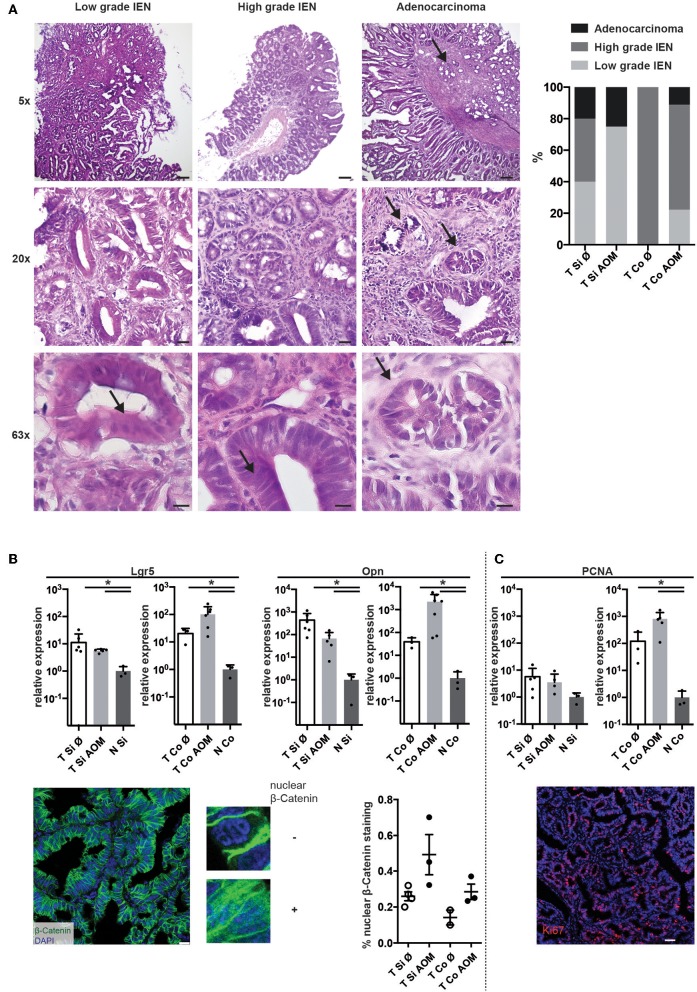
AOM-treatment leads to the development of high-grade colonic lesions with active Wnt-signaling and proliferation. (A) Exemplary images of H&E stained cryosections of tumors isolated from AOM-treated and non-treated Apc1638N/+ mice (taken with 5×, 20×, and 63× objectives). Scale bars: 100 μm (5×), 25 μm (20×), 10 μm (63×). Arrows indicate features of cell dedifferentiation and dysplasia such as pseudo-stratification, increased nucleus/cytoplasm ratios and abnormal nuclei positioning as well as invasion of the muscularis mucosae in adenocarcinomas. Proportions of low grade IEN, high grade IEN and adenocarcinoma are shown in the graph (Si untreated, n = 5; Si AOM n = 4; Co untreated, n = 1; Co AOM, n = 9). (B) Upper panel: relative mRNA expression of WNT target genes Lgr5 and Opn in tumors and normal intestinal tissue from tumor-bearing mice was measured by qRT-PCR (fold-change compared to normal tissue average, log(10) scale, mean + SEM, n = 3–6). Lower panel, left: representative image of immuno-fluorescence staining for β-Catenin in cryosections of a colon tumor. Scale bar: 50 μm. Zoomed images show nuclear and extranuclear localization of β-Catenin. Green: β-Catenin, blue: DAPI, 63× magnification. Right: quantification of nuclear β-Catenin staining of total β-Catenin staining in one field of view per mouse. Symbols indicate tumors from individual mice; mean + SEM (n = 2–3). (C) Upper panel: relative mRNA expression of Pcna in tumors and normal intestinal tissue from tumor-bearing mice was measured by qRT-PCR (fold-change compared to normal tissue average, log(10) scale, mean + SEM, n = 3–6, unpaired, two-tailed t-test). Lower panel: representative Ki67 staining of intestinal tumor tissue of an Apc1638N/+ mouse (20×, red: Ki67, blue: DAPI, Scale bar: 50 μm). *p < 0.05.